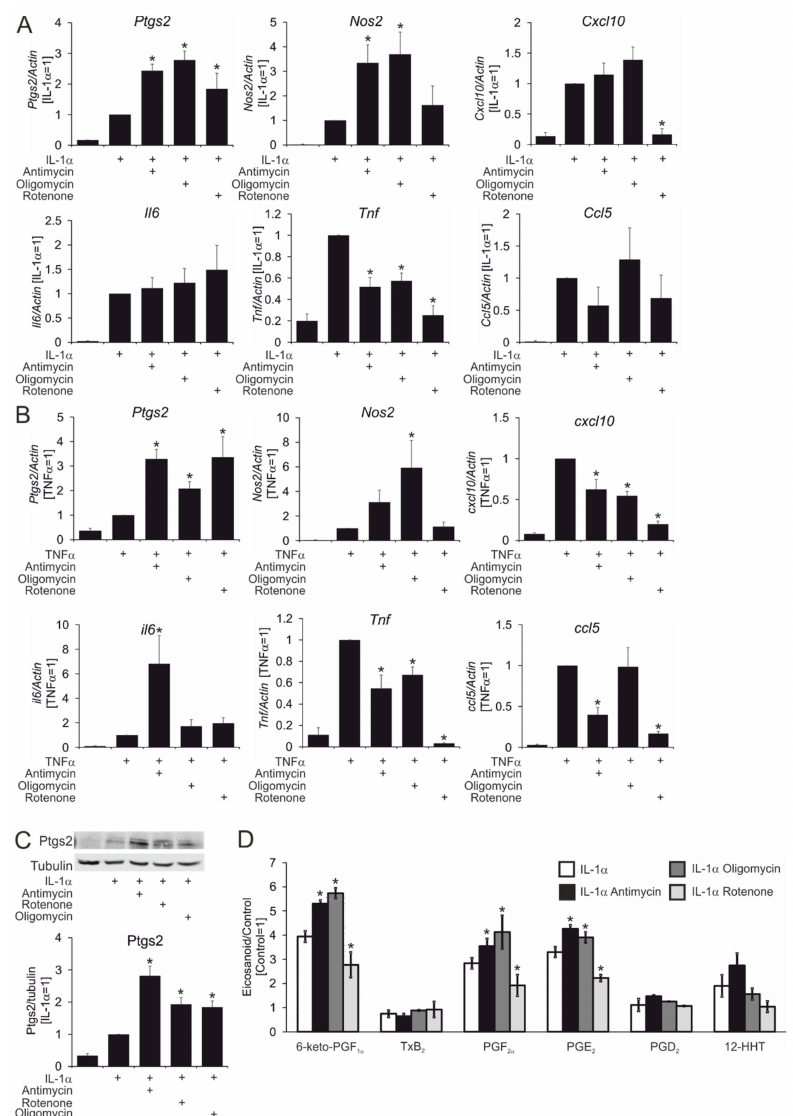
Figure 1. Inhibitors of mitochondrial activity increase prostaglandin endoperoxide synthase 2 (Ptgs2) expressioninratcorticalastrocytesexposedtopro-inflammatorycytokines. ( A , B )ThemRNAexpression of indicated genes in astrocytes treated for 3 hours with interleukin-1 α (IL-1 α )( A ) or with tumor necrosis factor- α (TNF- α ) ( B ); in both cases, cells were also treated with antimycin, oligomycin, or rotenone, as indicated. ( C ) Western blot analysis of Ptgs2 expression in astrocytes treated for 4 hours with IL-1 α in the presence or absence of rotenone, oligomycin, and antimycin, as indicated. ( D ) Comparative lipidomic analysis. Concentrations of eicosanoids in supernatants of astrocytes treated for 4 hours with IL-1 α in the presence or absence of rotenone, oligomycin, and antimycin, and measured using ultra performance liquid chromatography - tandem mass spectrometry. Note: *, p < 0.05 vs. IL-1 α or TNF α . Data represent mean values ± SE of 3 or 4 independent